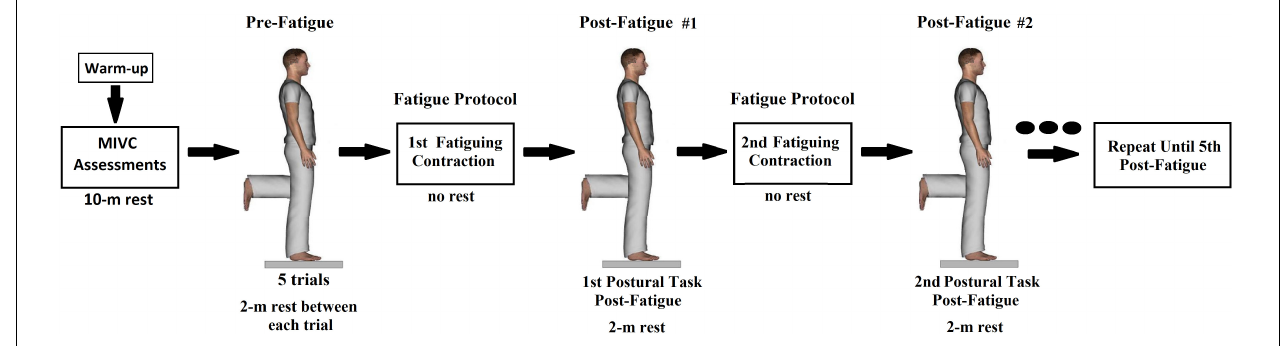
FIGURE 1 | Simplified representation of the experimental protocol.